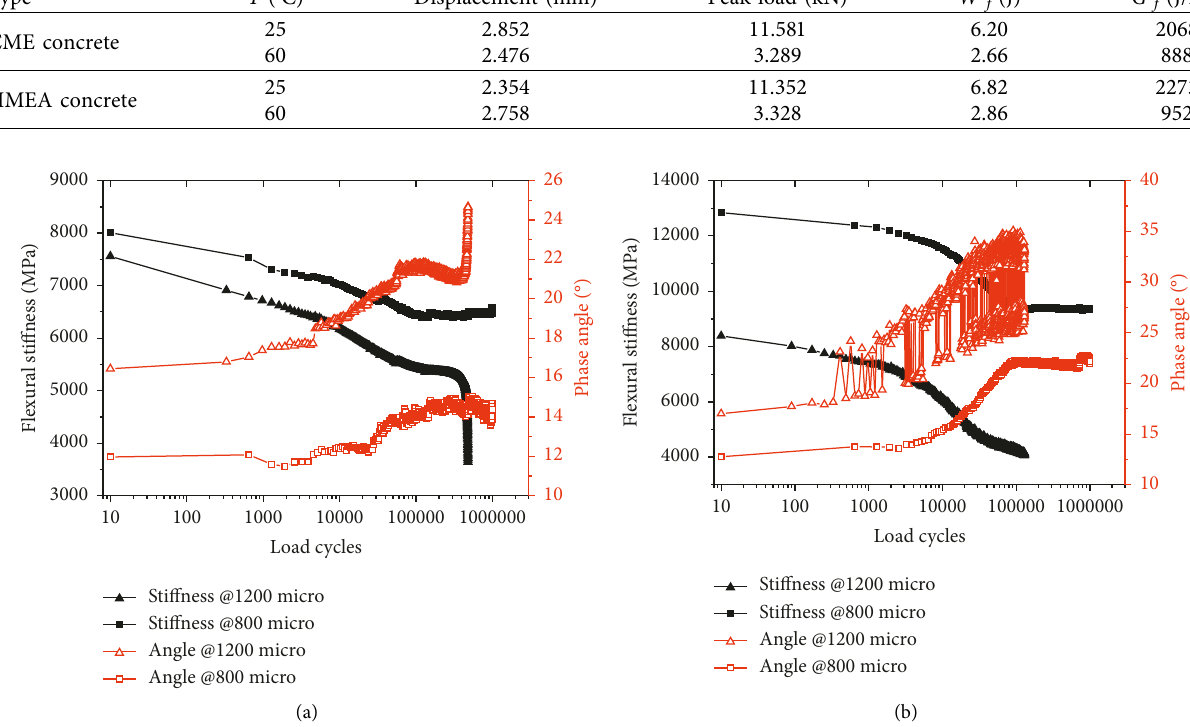
Figure 12: Flexural stiffness and phase angle versus load cycles. (a) CME concrete and (b) HMEA